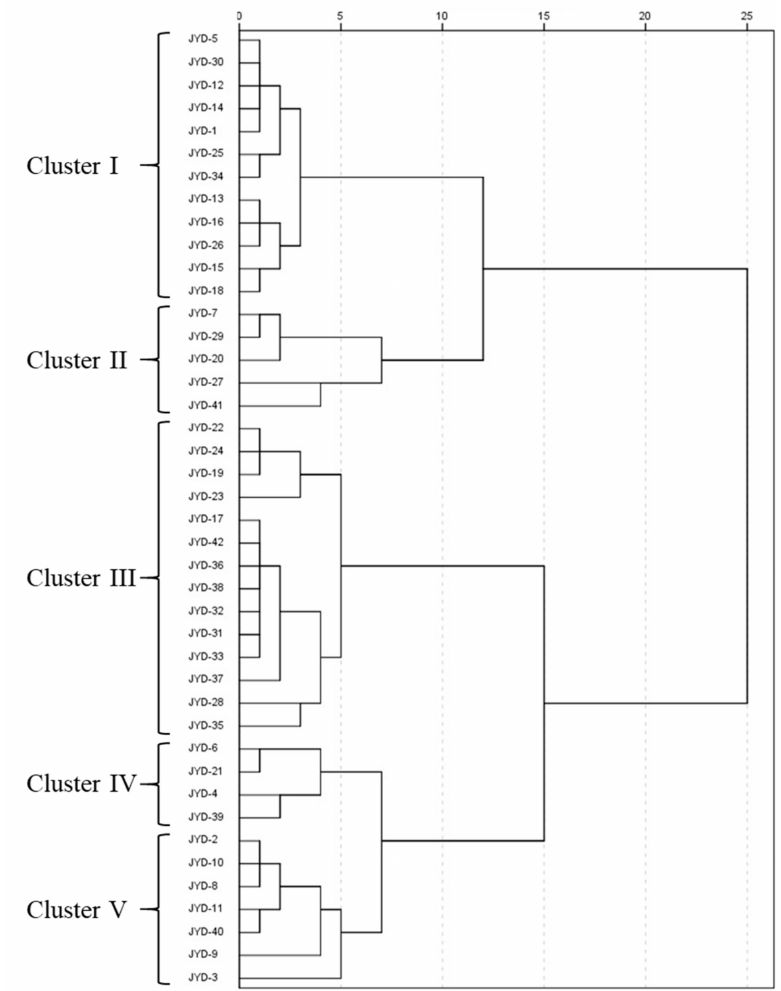
Figure 1. Cluster analysis of 42 tiger nut accessions based on the 14 agronomic and biochemical